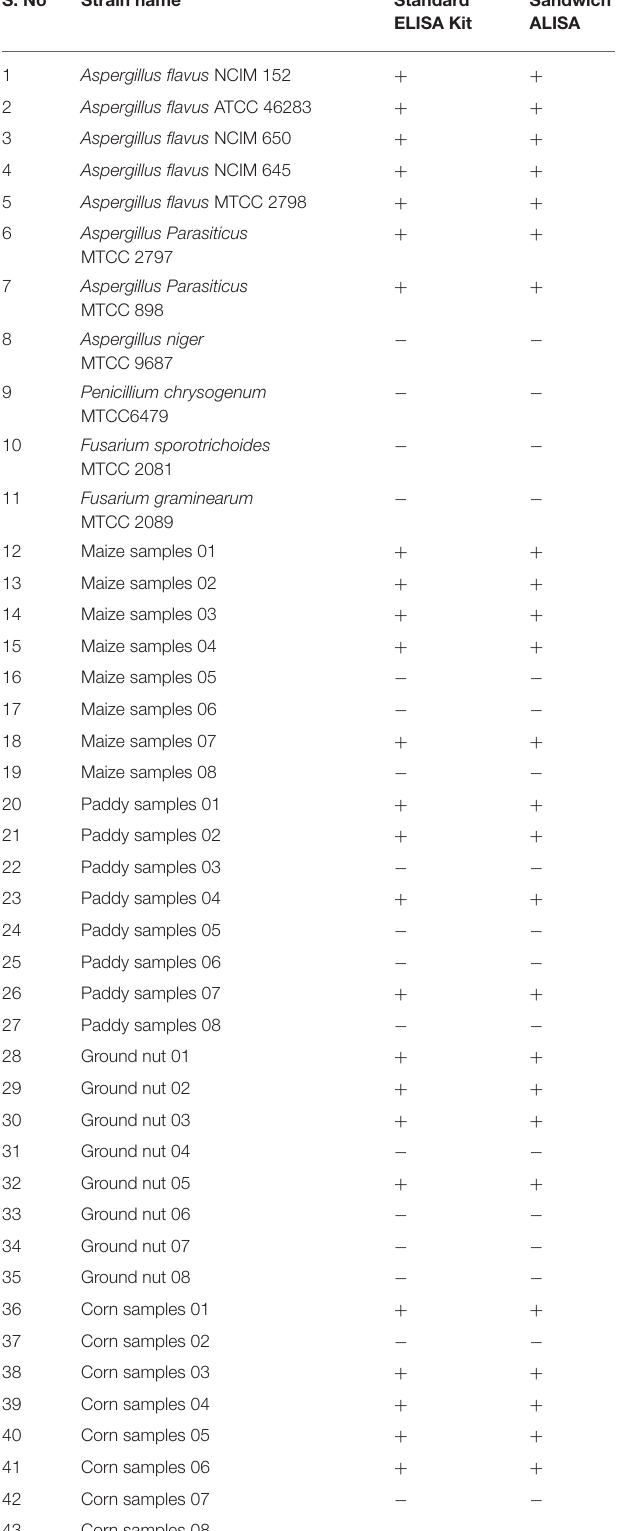
TABLE 2 | Evaluation of sandwich immunoassay against standard cultures and field samples. S.